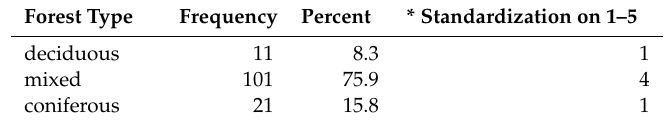
Table 2. Teachers’ forest type preferences when visiting a forest with kindergarten groups.